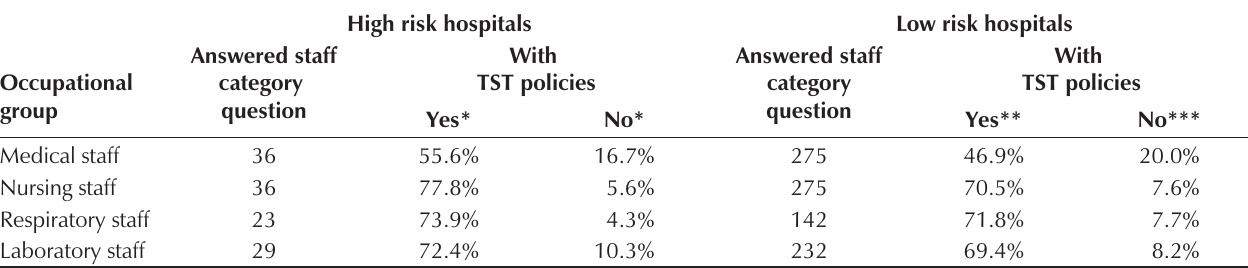
Tuberculin skin test (TST) policies by tuberculosis risk category and occupational group High risk hospitals Low risk hospitals